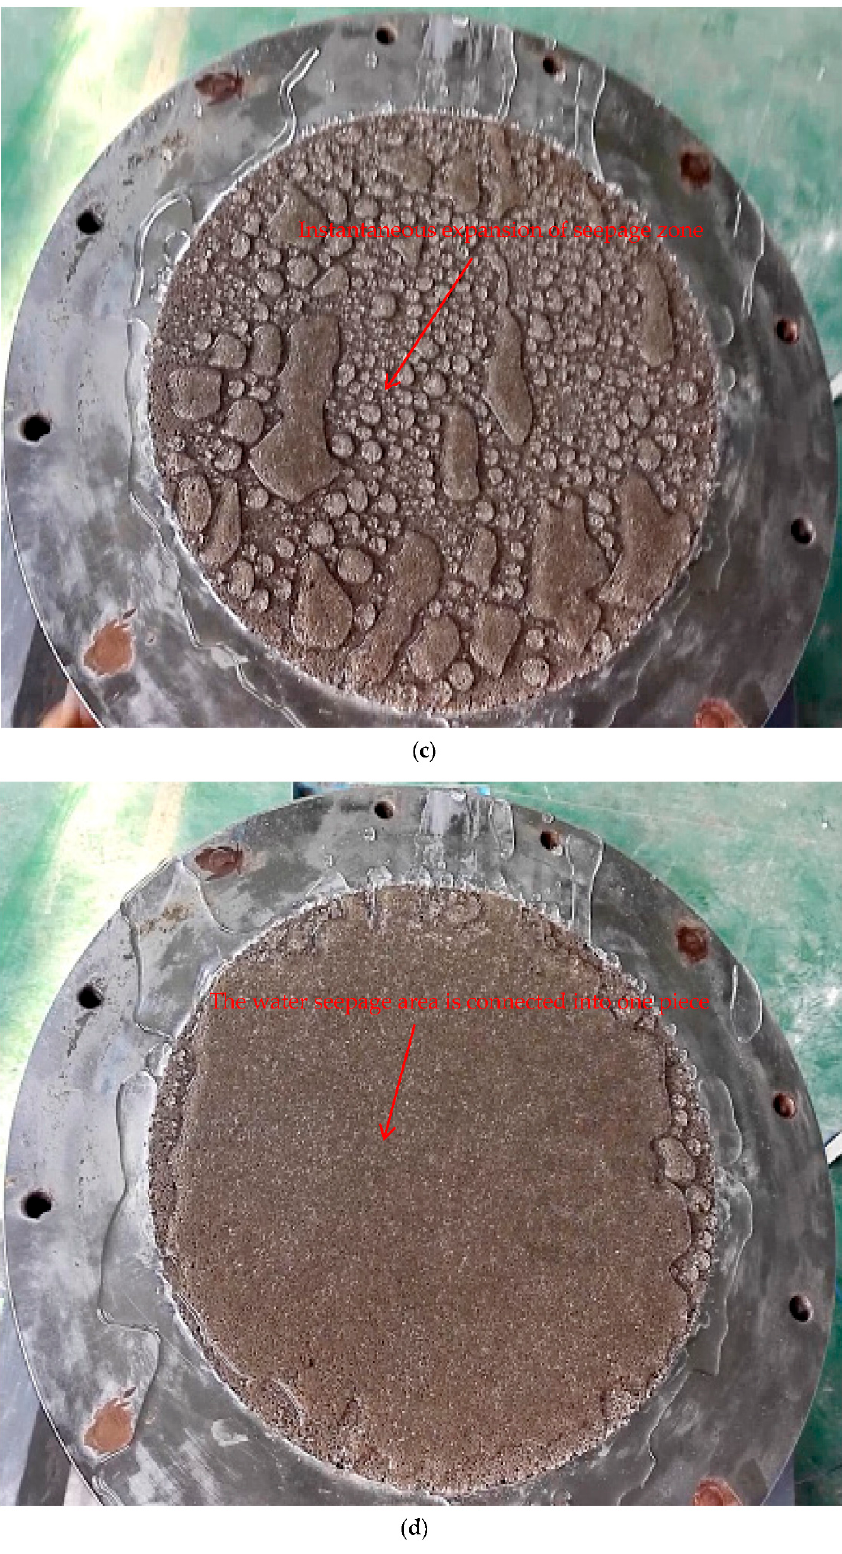
Figure 9. Water seepage stage at the bottom of arch. ( a ) The initial state. ( b ) Local water droplet attachment. ( c ) Instantaneous expansion of seepage zone. ( d ) The water seepage area is connected into one